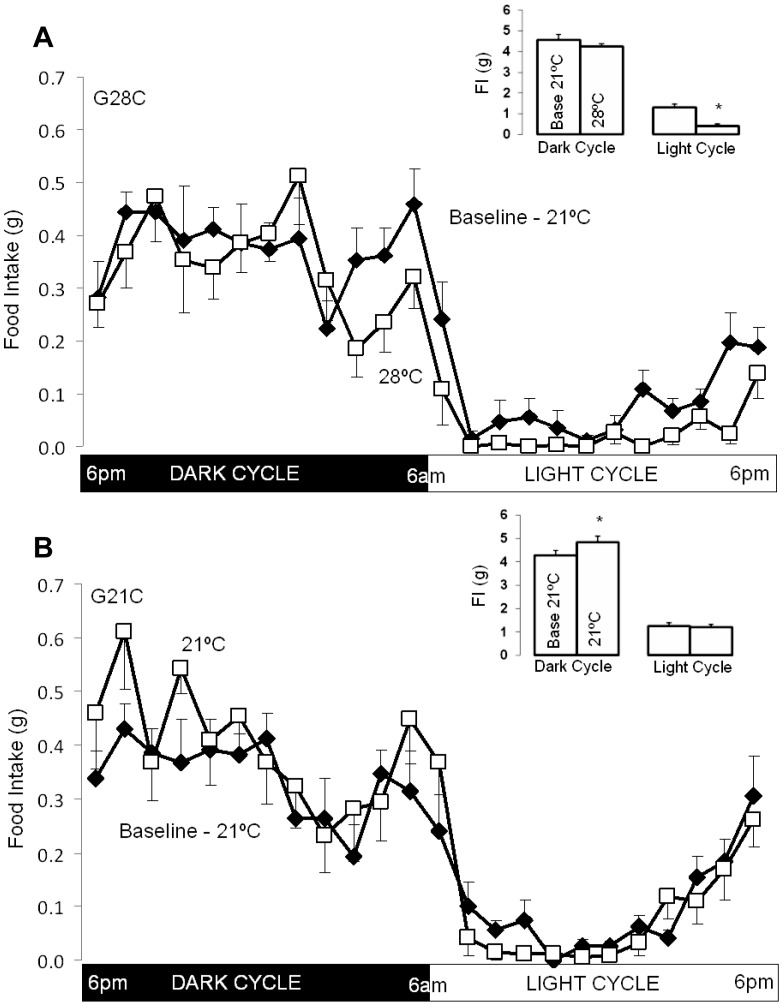
Effect of increased ambient temperature (Ta) on food intake (FI) in G28C and G21C groups.A. G28C group (n = 8). Mean hourly FI (g) during the entire photoperiod at baseline (21°C) and after increasing Ta to 28°C. Insert: Cumulative mean dark cycle and light cycle FI in G28C mice at baseline (Base 21°C) and after increasing Ta to 28°C (28°C). B. G21C group (n = 8). Mean hourly FI (g) during the entire photoperiod at baseline (21°C) and after maintaining Ta at 21°C. Insert: Cumulative mean dark cycle and light cycle FI in G21C mice at baseline (Base 21°C) and after maintaining Ta at 21°C (21°C). All data shown as means ± SEM for 3 consecutive days, * signifies p<0.05 by pair-wise t-test.